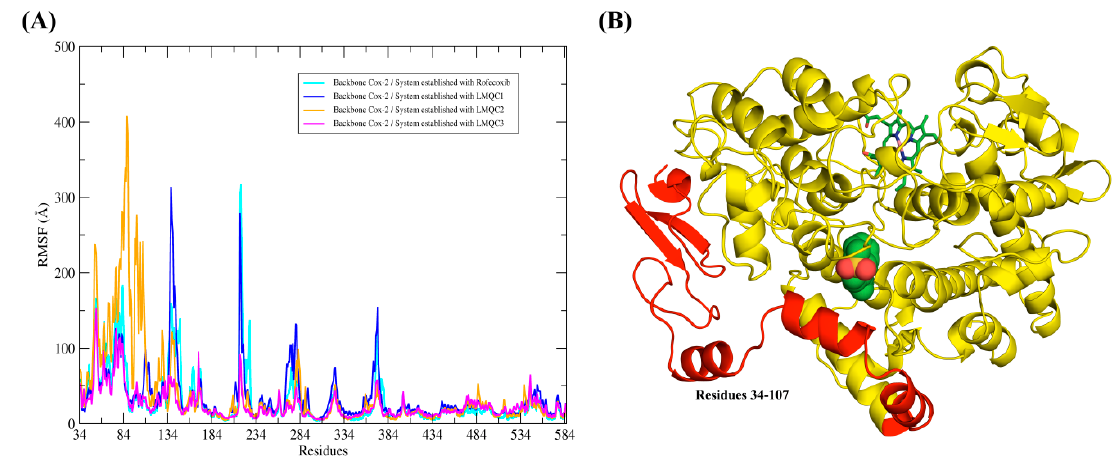
Figure 7. Shows the profile of the root-mean-square fluctuation (RMSF) plot for the h COX-2 protein backbone that was extracted from the molecular dynamics trajectories. RMSF plot overlay for all complexes. ( A ) Profile of the RMSF graphs and ( B ) Representation of the protein, where the residues (37–107) that showed the greatest fluctuations were highlighted in red color.